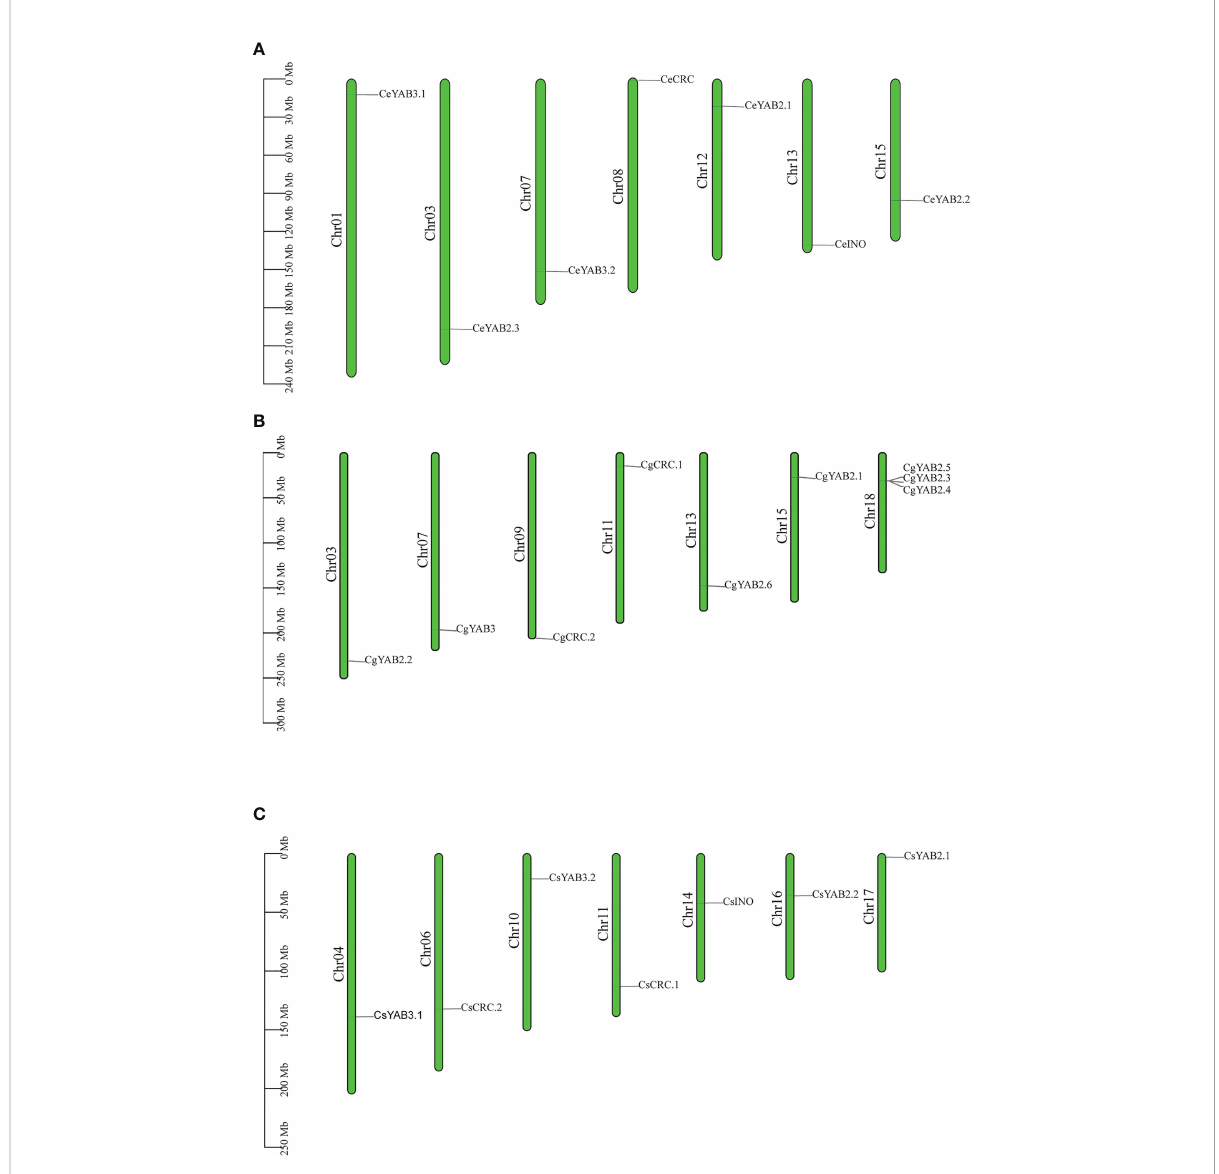
FIGURE 3 Chromosome distribution in three Cymbidium species. (A) Chromosome distribution in C. ensifolium . (B) Chromosome distribution in C. goeringii . (C) Chromosome distribution in C. sinense